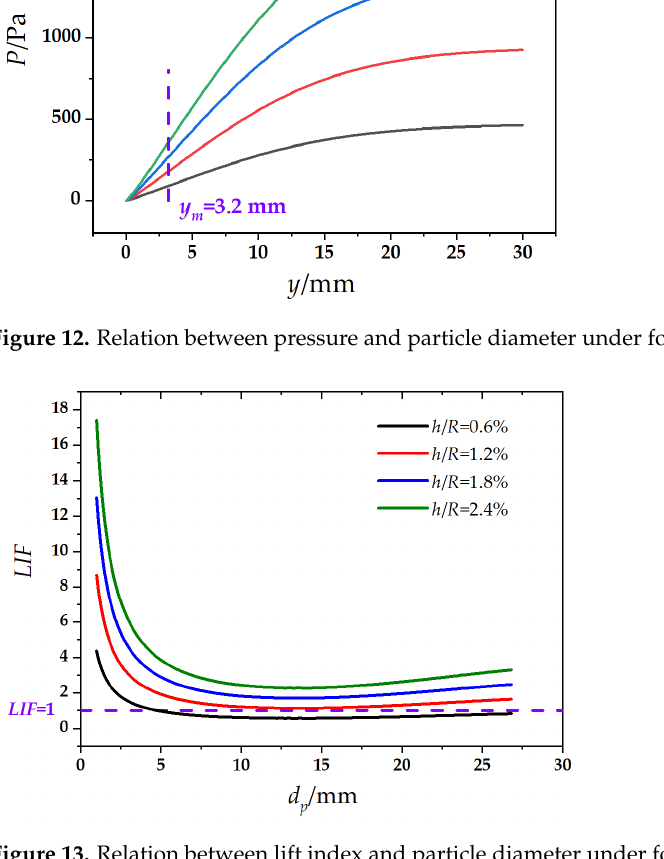
1.75 m/s to 0.72m/s with the increase of H / d p from 3 to 12. In Figure 15, the four P - y curves present an “ S ” shape. As H / d p increased, pressure first increased and then dropped, showing peak characteristics. The assumed threshold of H / d p was 3 for particles with different diameters. Figure 14. Relation between velocity and particle diameter under four different H / d p .